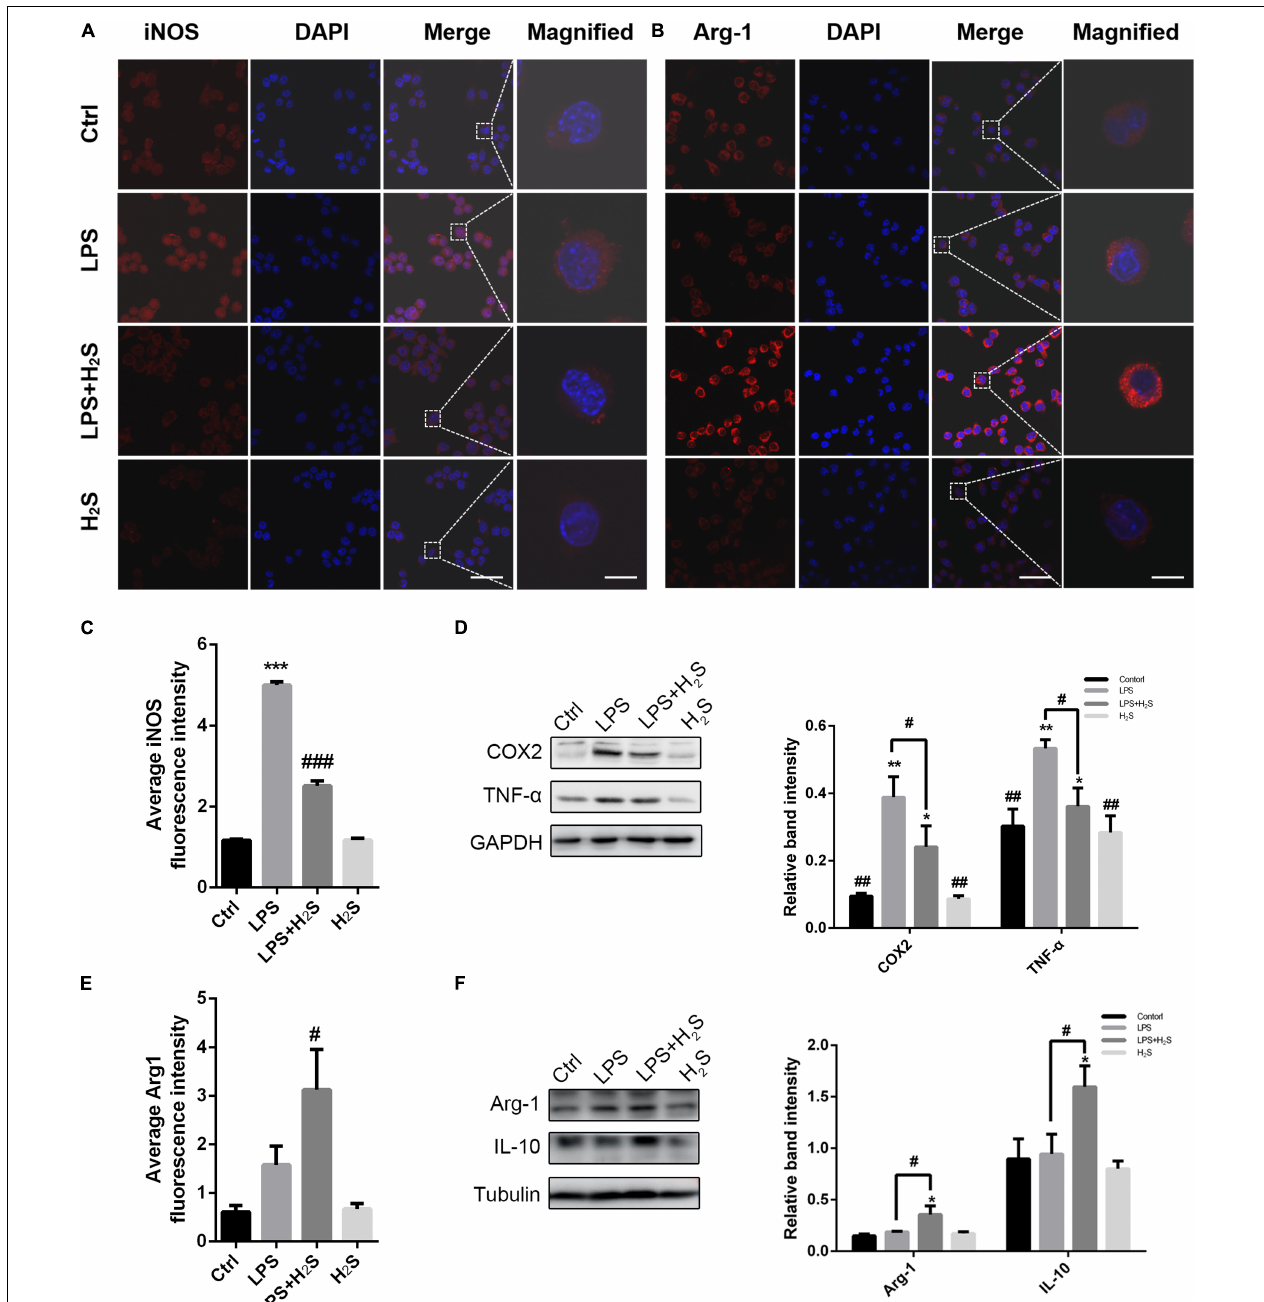
FIGURE 4 | The H 2 S donor downregulated the levels of microglial pro-inflammatory profile in vitro . (A–C,E) Immunofluorescent staining and quantification of iNOS and Arg1 in lipopolysaccharide (LPS)-treated BV2 cells. Scale bars, 50 µ m for the original images and 10 µ m for the magnified images. n = 6 per group. *** p < 0.001 vs Control, # p < 0.05, ### p < 0.001 vs LPS. Statistical significance was determined by two-way ANOVA with Bonferroni post hoc tests. (D,F) Expression levels of microglial pro-inflammatory markers (COX2, TNF- α ) and microglial anti-inflammatory markers (Arg1, IL-10) in BV2 cells were determined by Western blotting. The H 2 S donor decreased the expression of pro-inflammatory markers and upregulated the expression of anti-inflammatory markers in LPS-induced inflammation model of microglia. n = 3 per group. * p < 0.05, ** p < 0.01 vs Control, # p < 0.05, ## p < 0.01 vs LPS. One-way ANOVA with Bonferroni post hoc tests.